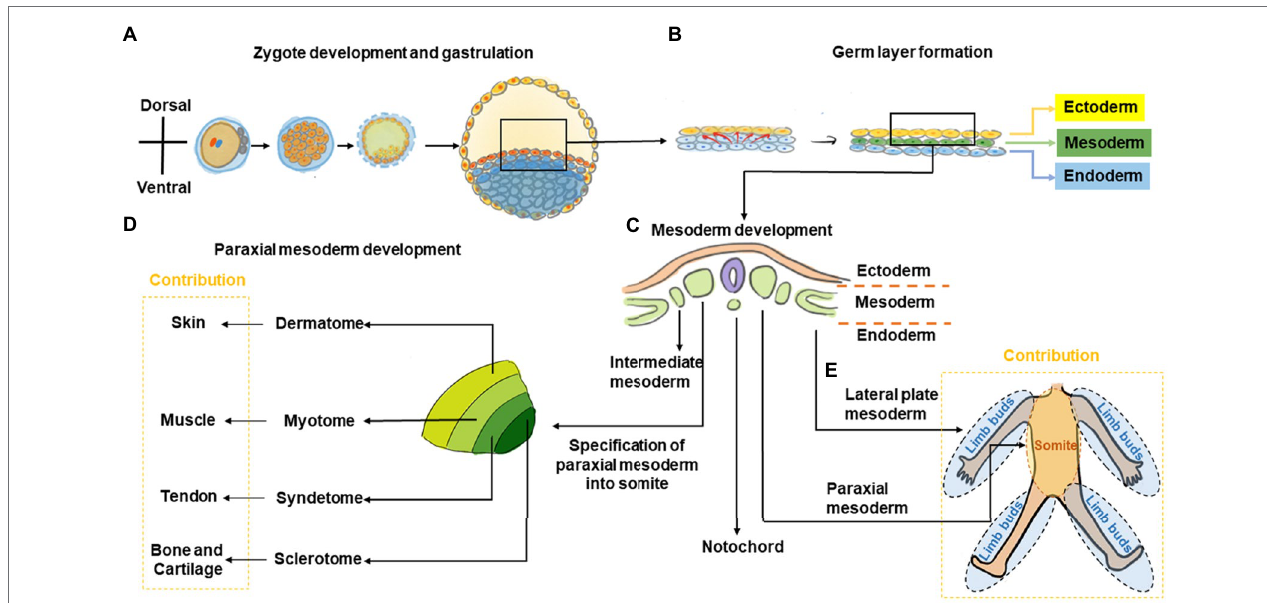
FIGURE 1 | Graphic overview of musculoskeletal development in the trunk and limbs. (A) The fertilized zygote transitions through several embryonic structures before forming the blastula, which contains the two-layered embryonic or germ disk consisting of epiblast and hypoblast. (B) As development proceeds, a tri-laminar gastrula structure consisting of ectoderm, mesoderm, and endoderm layers is formed. (C) Further during gastrulation, the mesoderm subdivides into the paraxial, intermediate, and lateral plate mesoderm. (D) Subsequently, somites are formed from paraxial mesoderm. The somite further subdivides into the sclerotome, syndetome, myotome, and dermatome regions, which contribute toward cartilage and bone, tendon, muscle, and skin elements, respectively. (E) The lateral plate mesoderm gives rise to the limb bud, which forms the cartilage/bone and tendon elements of the appendicular skeleton, while migrating myoblasts from the myotome contribute toward muscle